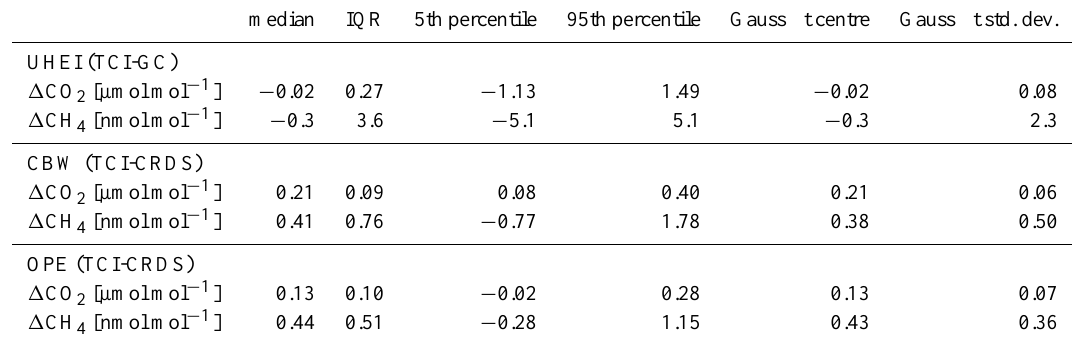
Table 1. Descriptive statistics of the individual CO 2 and CH 4 differences for the Heidelberg reference station and the two ICOS Demonstration Experiment stations. The median and the inter-quartile range (IQR) of the distributions are given in the first two columns followed by the 5th and 95th percentile. The last two columns state the results of the fitted Gaussian distribution. median IQR 5th percentile 95th percentile Gauss fit std.